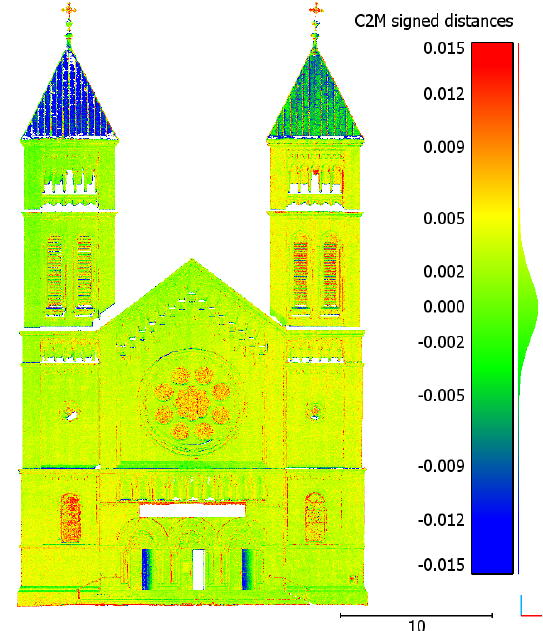
Figure 6. Cloud-to-mesh deviations computed between the meshed point cloud issued by Trimble TX8 and the Trimble SX10 whole point cloud. Deviations (in meters) are projected on SX10 point